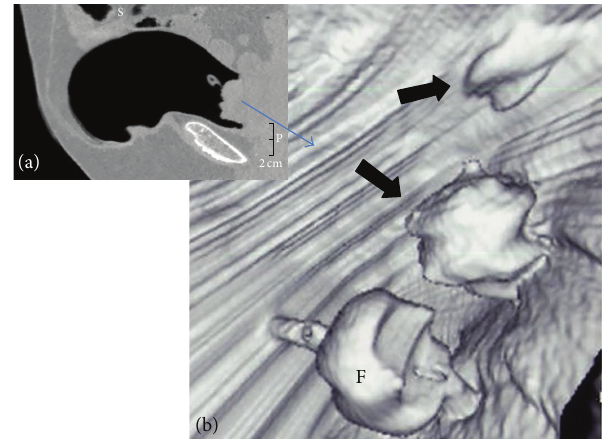
Figure 2: Exophytic lesion arising from the posterior side of the bladder wall. (a) MDCT image (sagittal plane) and (b) VC image (after 3D reconstruction). The pathology report revealed a pT1 TCC of the bladder.